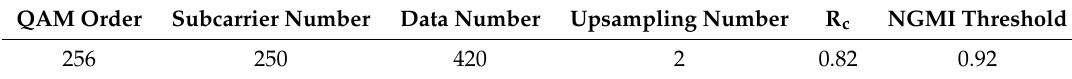
Table 2. The modulation